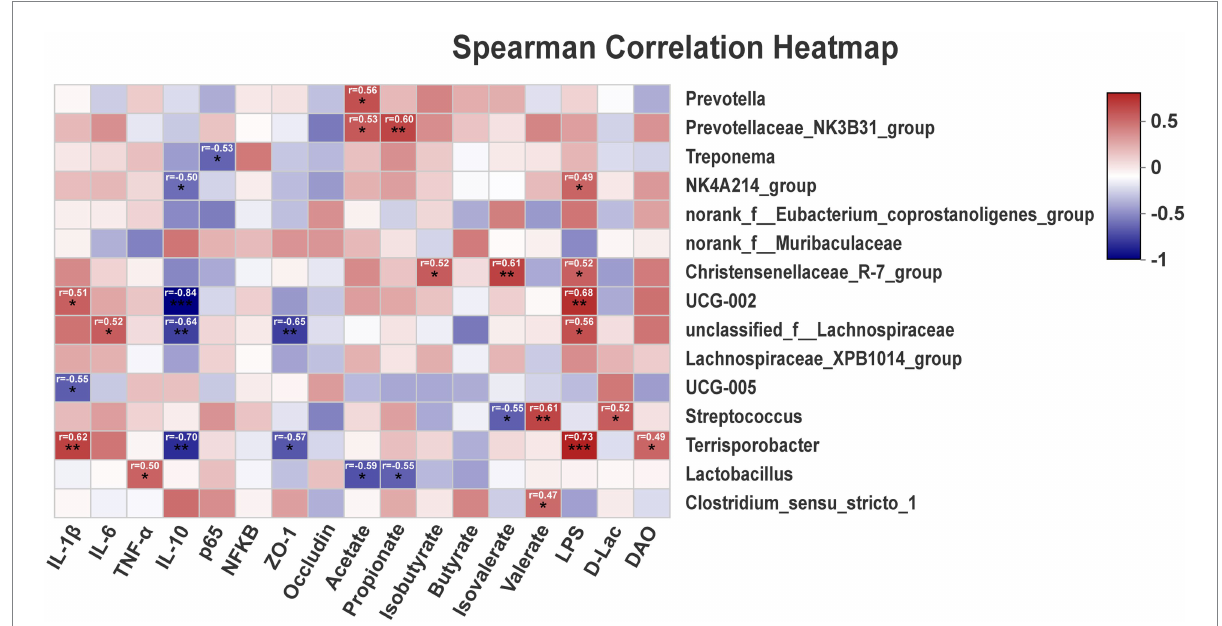
FIGURE 6 The correlation of intestinal microbiota, intestinal barrier, SCFAs, inflammatory cytokines, and blood biochemical parameters. r = Pearson correlation coefficient; p = significance level, * p < 0.05, ** p < 0.01, *** p < 0.001. The p -value below 0.05 was considered significant, and absolute value of r higher than 0.5 was considered a strong correlation